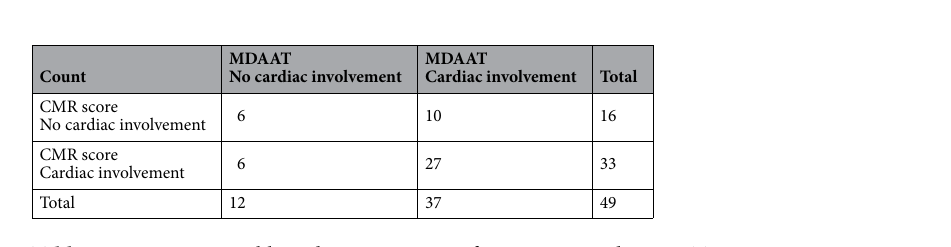
Table 4. Contingency table and McNemar test of CMR score and